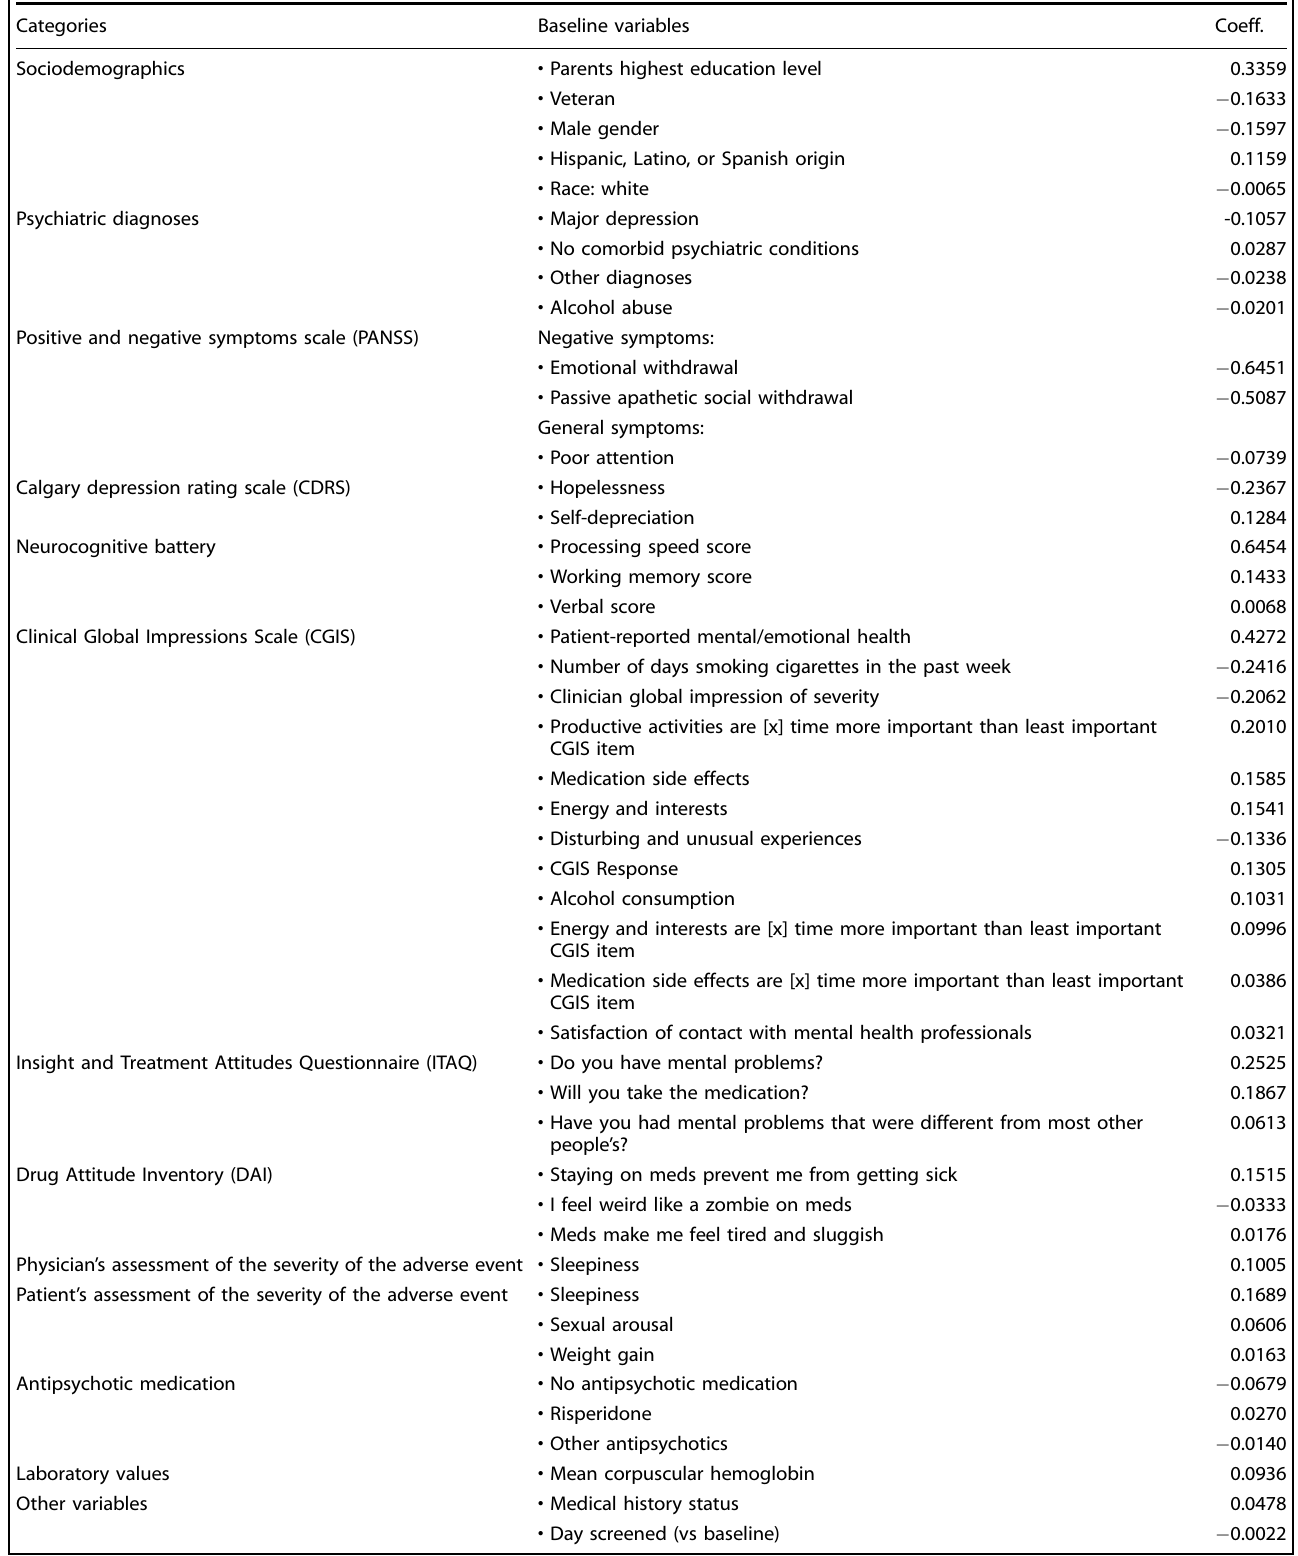
Table 2. Linear regression of QoL at the 12-month visit using baseline variables. N =